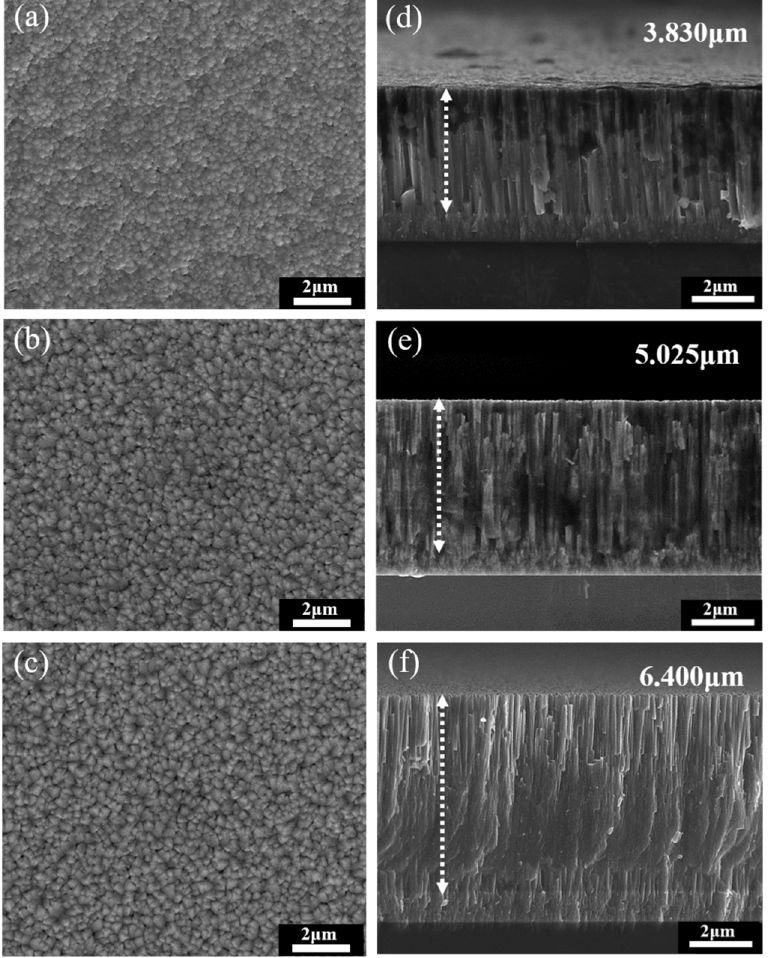
Figure 5. SEM morphologies of ( a – c ) over-view and ( d – f ) cross-section of the CrN thin films deposited for ( a , d ) 2 h, ( b , e ) 2.5 h, and ( c , f ) 3 h, respectively.